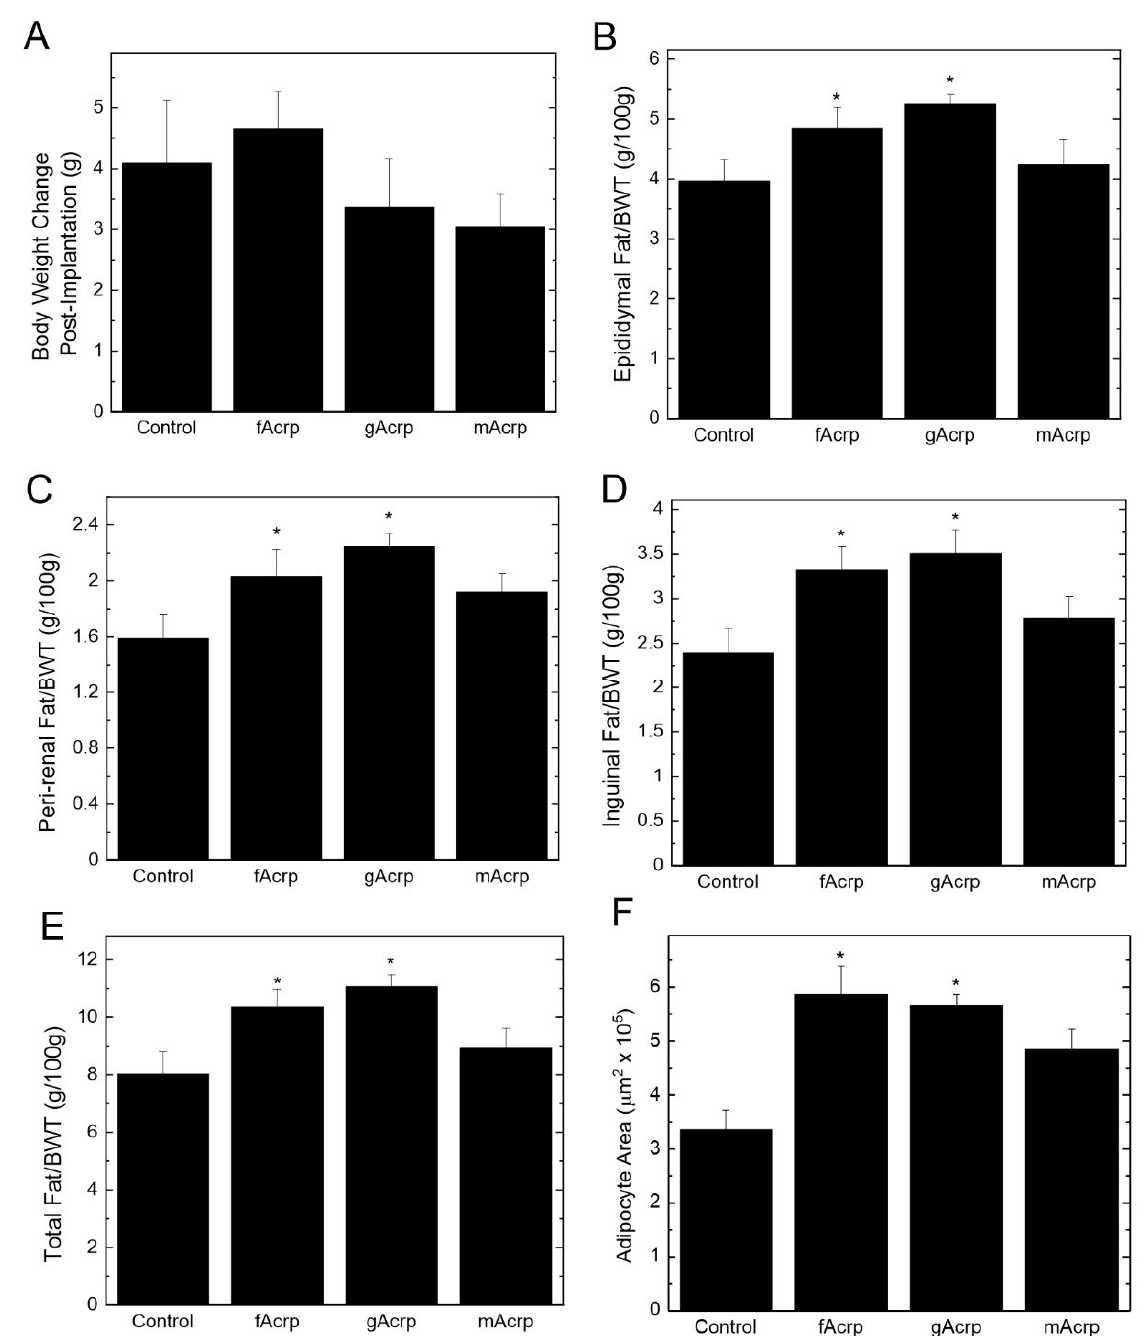
Figure 6. Comparison of fAcrp and gAcrp on body weight and adipose tissue parameters. ( A ) Change in body weight over the 4-week infusion period. ( B – D ) Weight of epididymal ( B ), peri-renal ( C ) and inguinal ( D ) fat pads relative to body weight (BWT) at the end of the infusion period. ( E ) Sum of the weights of the 3 major fat pads shown in panels ( B – D ) relative to BWT. For panels ( A – D ), mean ± sem was determined from n = 10 animals per group. ( F ) Adipocyte size was determined using ImageJ; a minimum of 100 cells were analyzed from three images taken of sections of epididymal fat pads. Mean ± sem was based on 5 animals per group. * p < 0.05 relative to Control for all panels. Panels ( A – E ) by ANOVA and Duncan’s multiple range test; Panel ( F ) by Kruskal–Wallis test and least significant difference